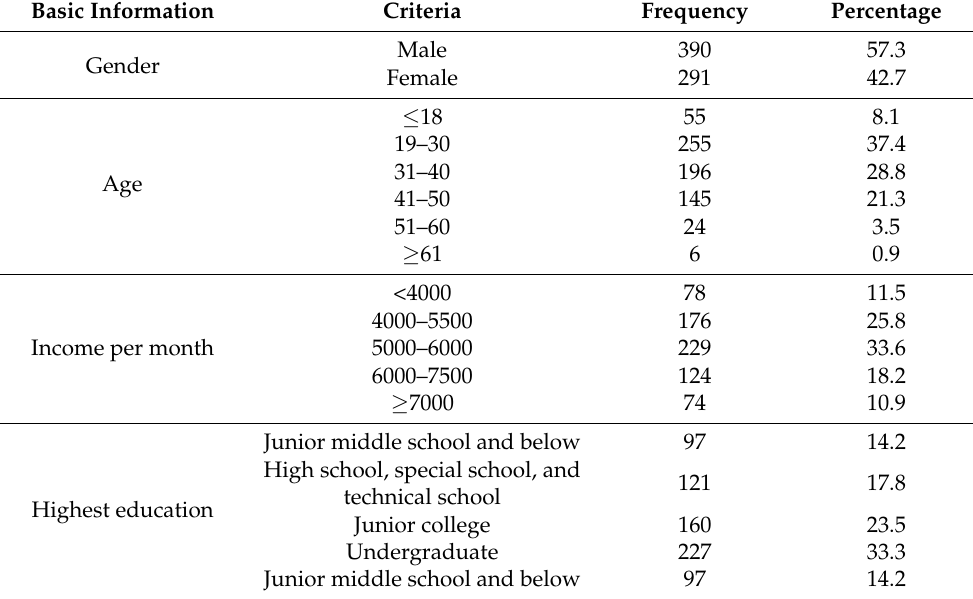
Table 1. Descriptive statistic